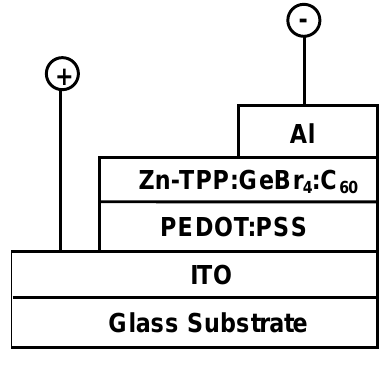
Figure 1. Structure of bulk heterojunction solar cells.